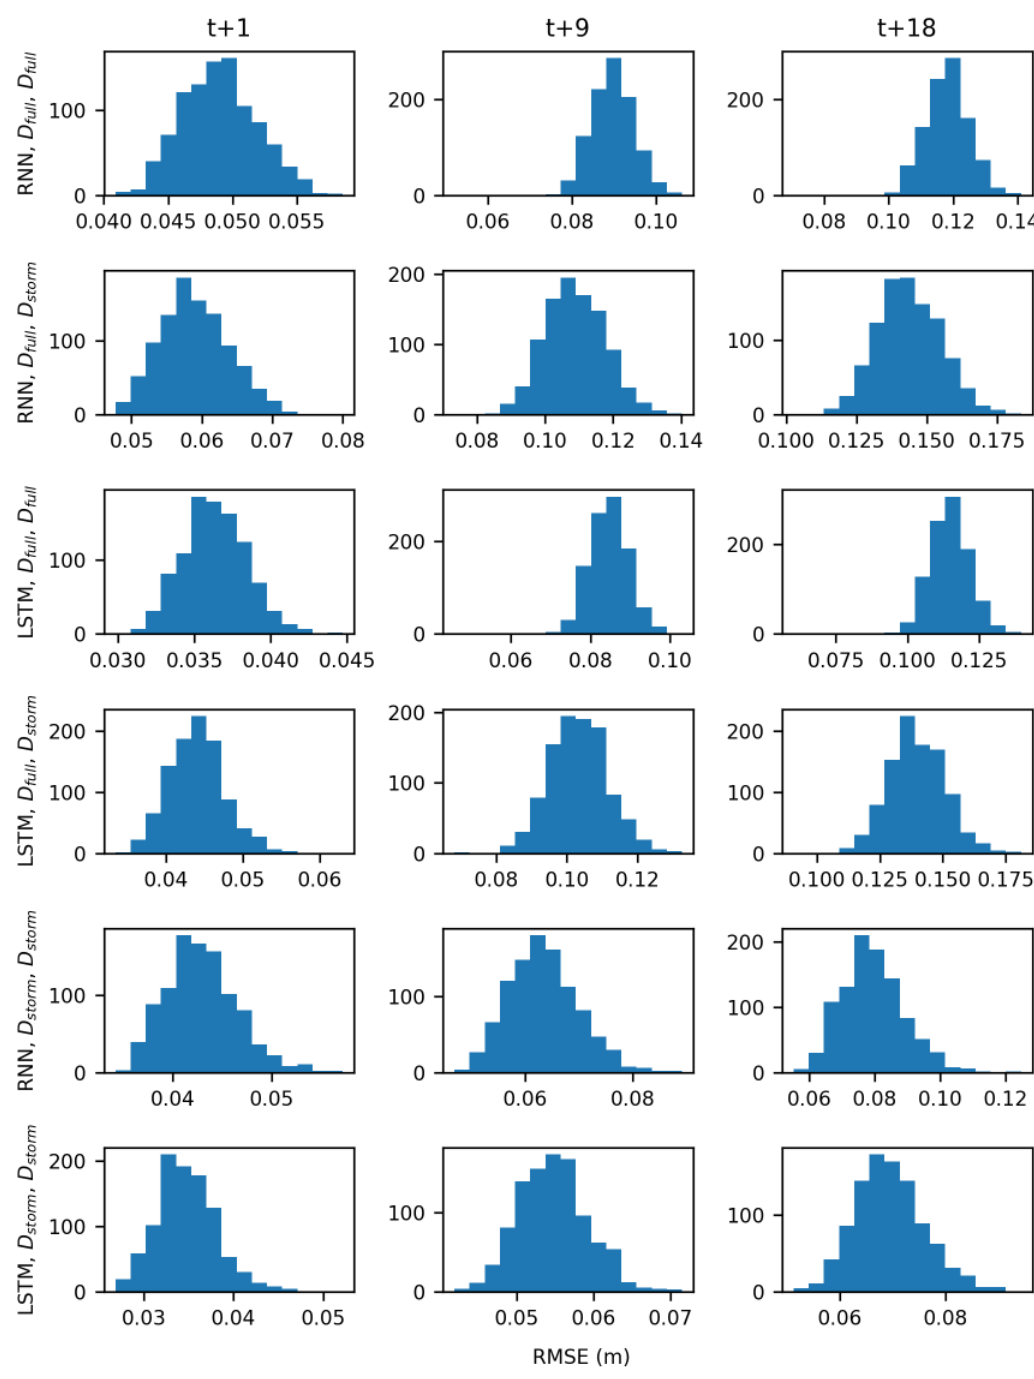
Figure A1. RMSE distributions for GW1 using observed data. Columns represent the forecast horizons t + 1, t + 9, and t + 18. Rows are specified as model type, training data, and testing data.